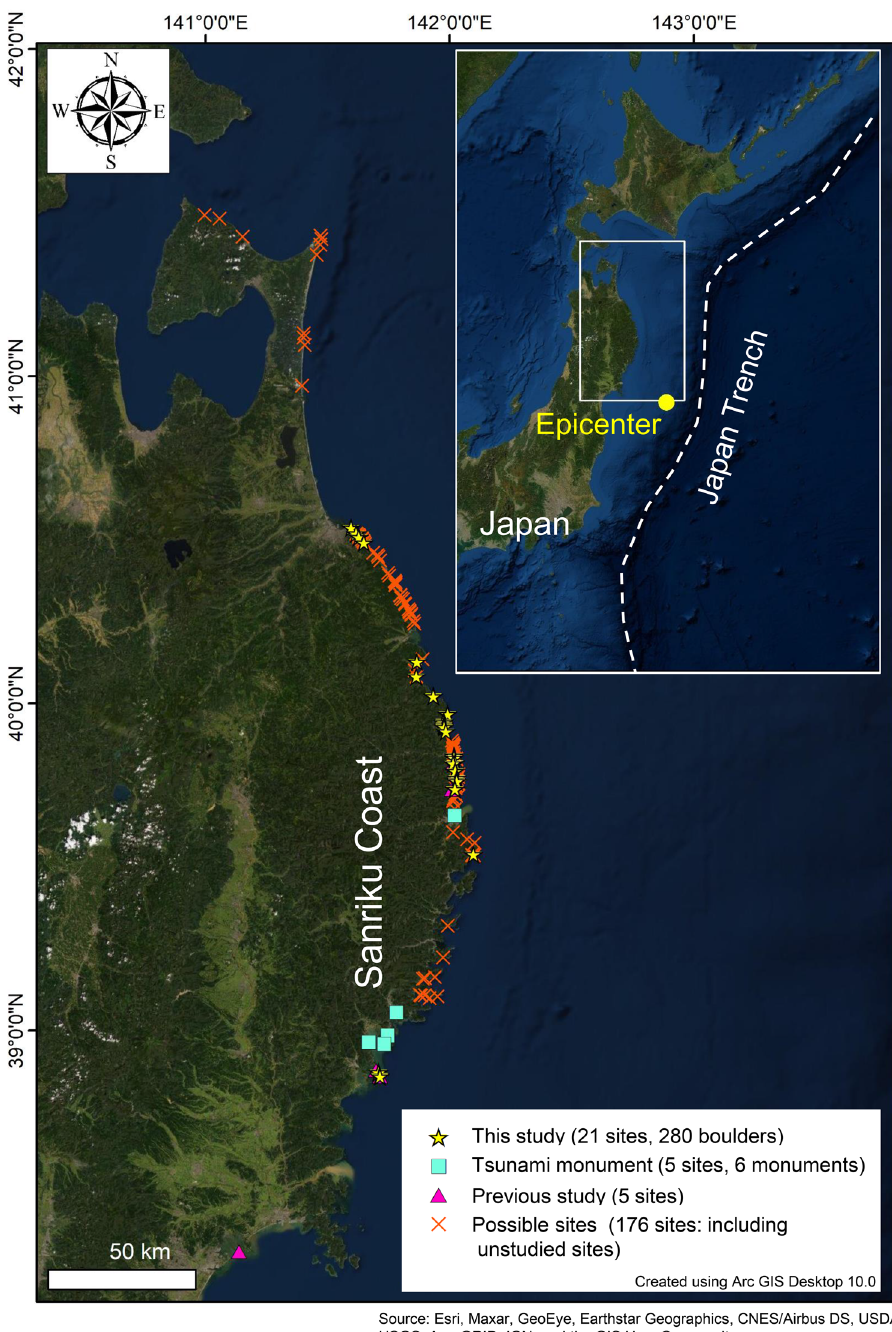
Figure 1. Map showing our surveyed sites, preliminarily selected sites (not surveyed), and sites studied for earlier works 5–7 . Satellite image “World Imagery with Metadata” is provided by esri atlas and the map was generated, using Arc GIS Desktop 10.0. Source: Esri, Maxar, GeoEye, Earthstar Geographics, CNES/Airbus DS, USDA, USGS, AeroGRID, IGN, and the GIS User